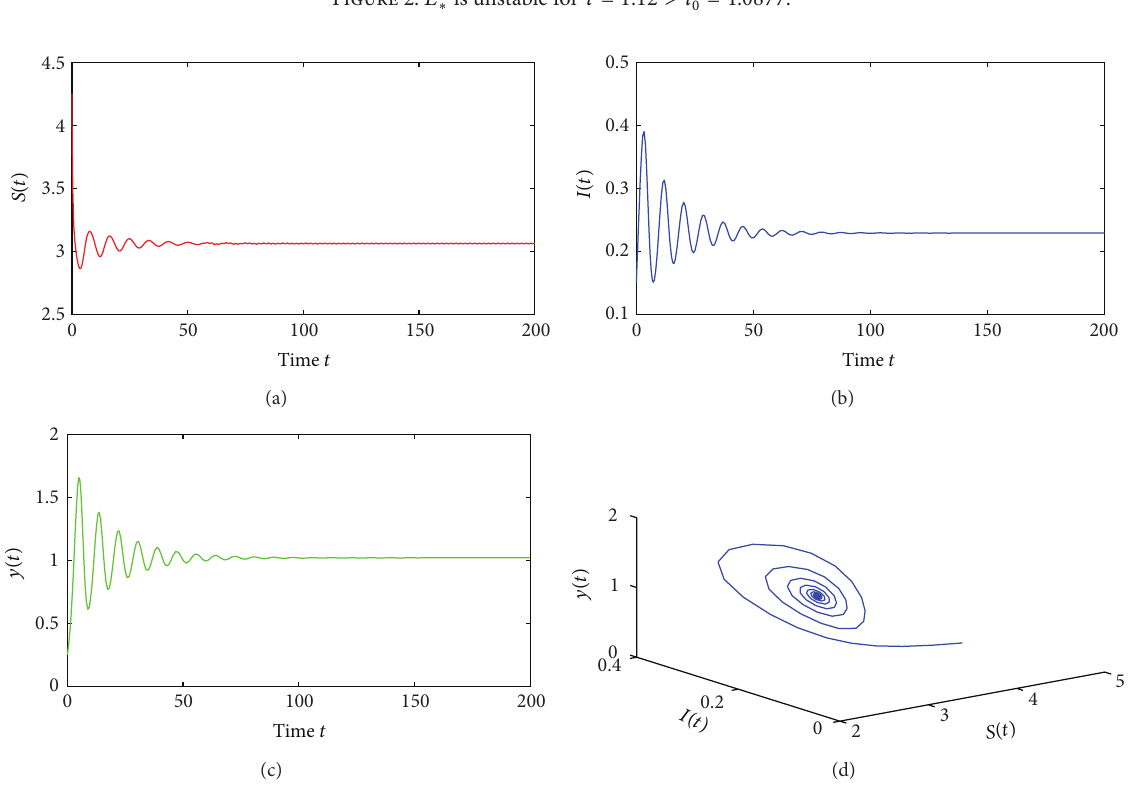
Figure 3: 𝐸 ∗ is locally asymptotically stable for 𝜏 = 1.65 < 𝜏 󸀠 0 = 1.8034